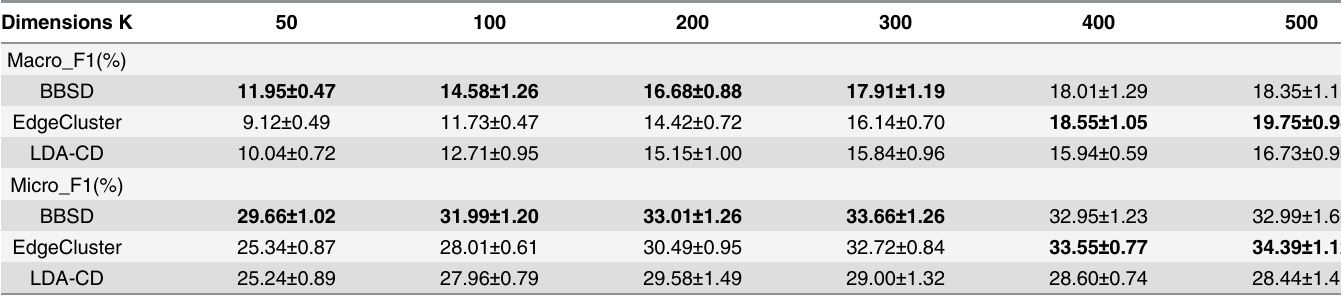
Table 5. Parameter sensitivity to social dimensions on Blogcatalog (LP = 90%). Dimensions